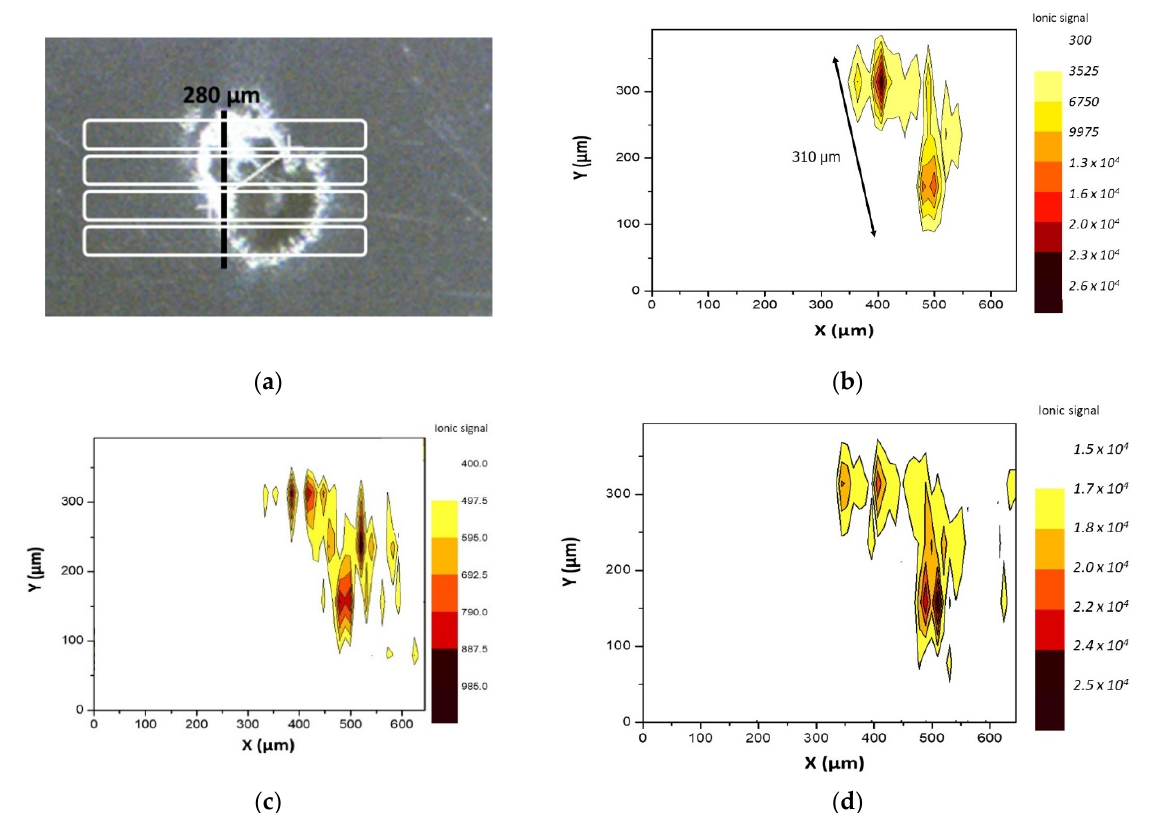
Figure 2. Defect found on film # 1 requiring multiple rasters. ( a ) laser line scans required for complete defect sampling and ( b ) 27 Al; ( c ) 98 Zr and ( d ) 24 Mg signal distributions within it.